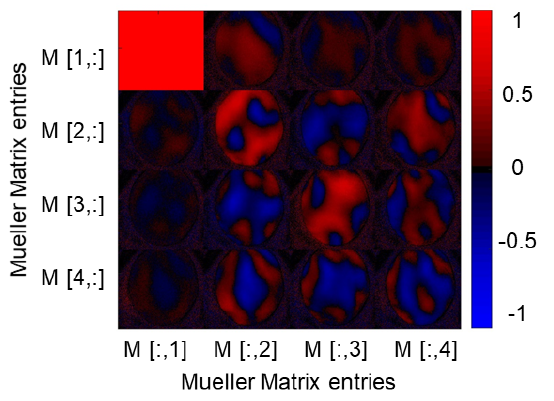
Figure 2. Result of a MM measurement in the transmission mode of a porcine cornea sample at a wavelength of 532 nm. The sample has a polarization-changing effect, as obvious from the non-zero entries of the different matrix elements, essentially all, which are normalized to the M ( 1,1 ) entry. However, the size of the effect is not homogeneously distributed over the surface of the cornea, which is evident from the individual entries and probably due to non-optimal sample